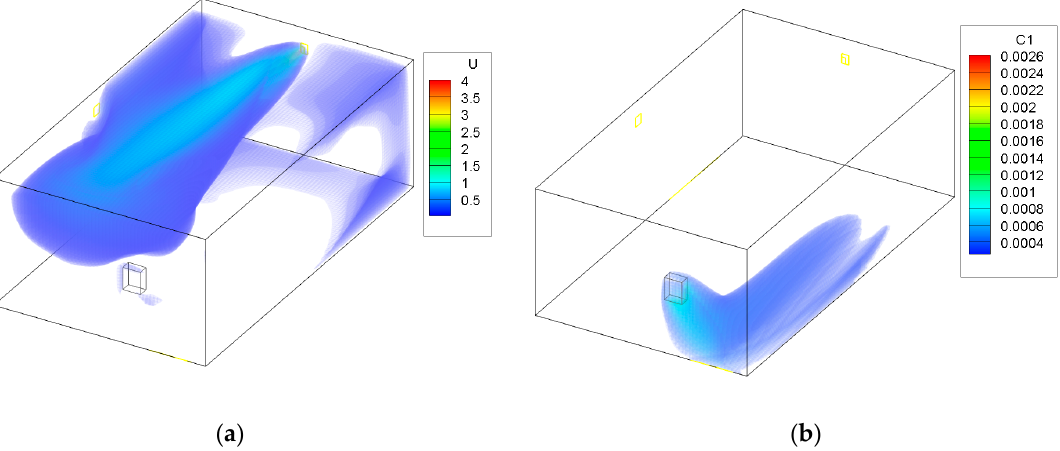
Figure 4. Case 3—medium flow and medium area of the ATD; ( a ) air velocity (m/s), ( b ) CO contrac- tion (kg/kg).